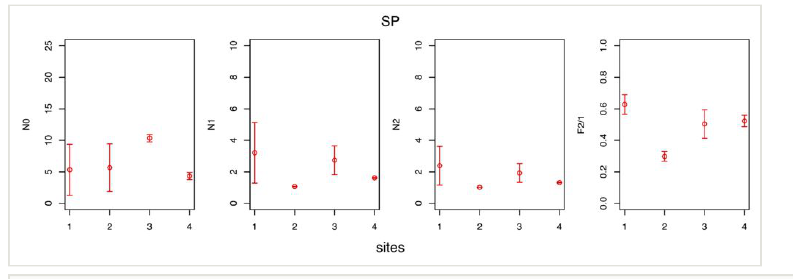
Figure 7. Variability of the observed species diversity and eveness along the sites (1, 2, 3, 4) transect during the spring (SP) survey. Diversity was measured using the Hill numbers N0, N1 and N2, whereas eveness was measured with the F2/1 index.